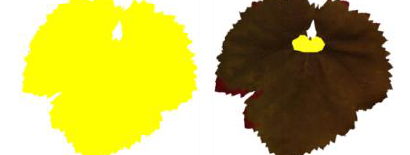
Figure 3. Masks for dataset production: left part shows the whole leaf- based mask; at right, is an example depicting the low midrib-based mask